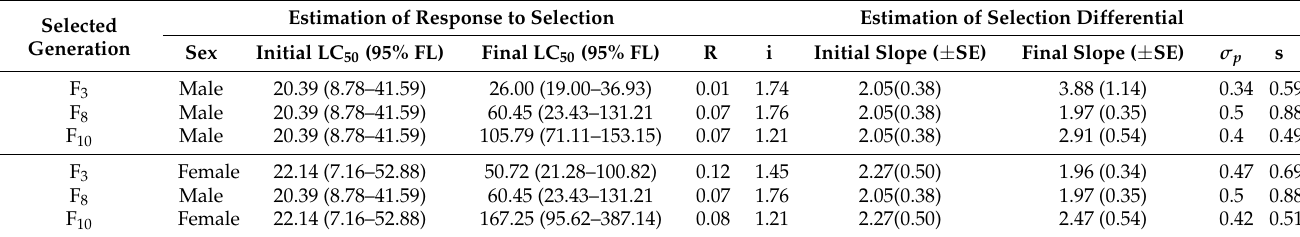
Table 3. Estimation of response to selection ( R ) and selection differential ( S ) of spinosad-selected adult population of D. suzukii . Selected Generation